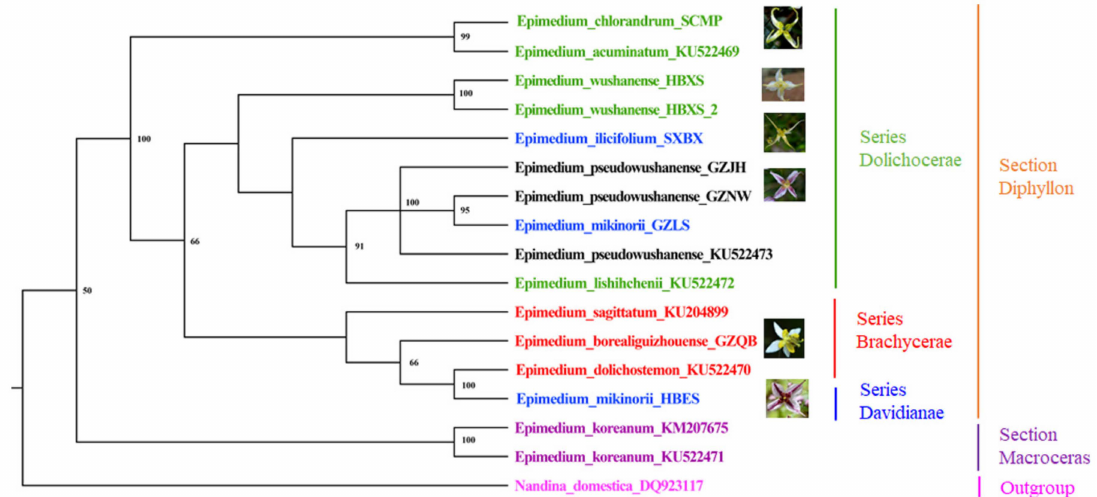
Figure 7. Phylogenetic relationships of 11 Epimedium species constructed based on the 87 protein-coding genes with maximum likelihood (ML). Numbers at the nodes represent ML bootstrap values. Stearn’s classification for each species is represented by di ff erent color, and species in the same series are represented by the same